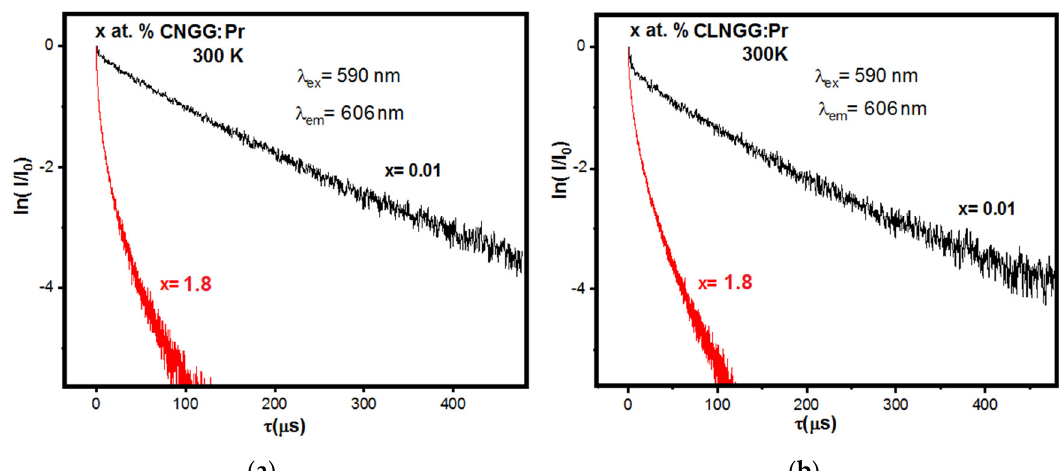
Figure 13. Emission kinetics of the 1 D 2 level of Pr 3+ ions in CNGG:Pr ( a ) and CLNGG:Pr ( b ) samples. (Reprinted with permission from Ref. [24], copyright 2019, Elsevier).